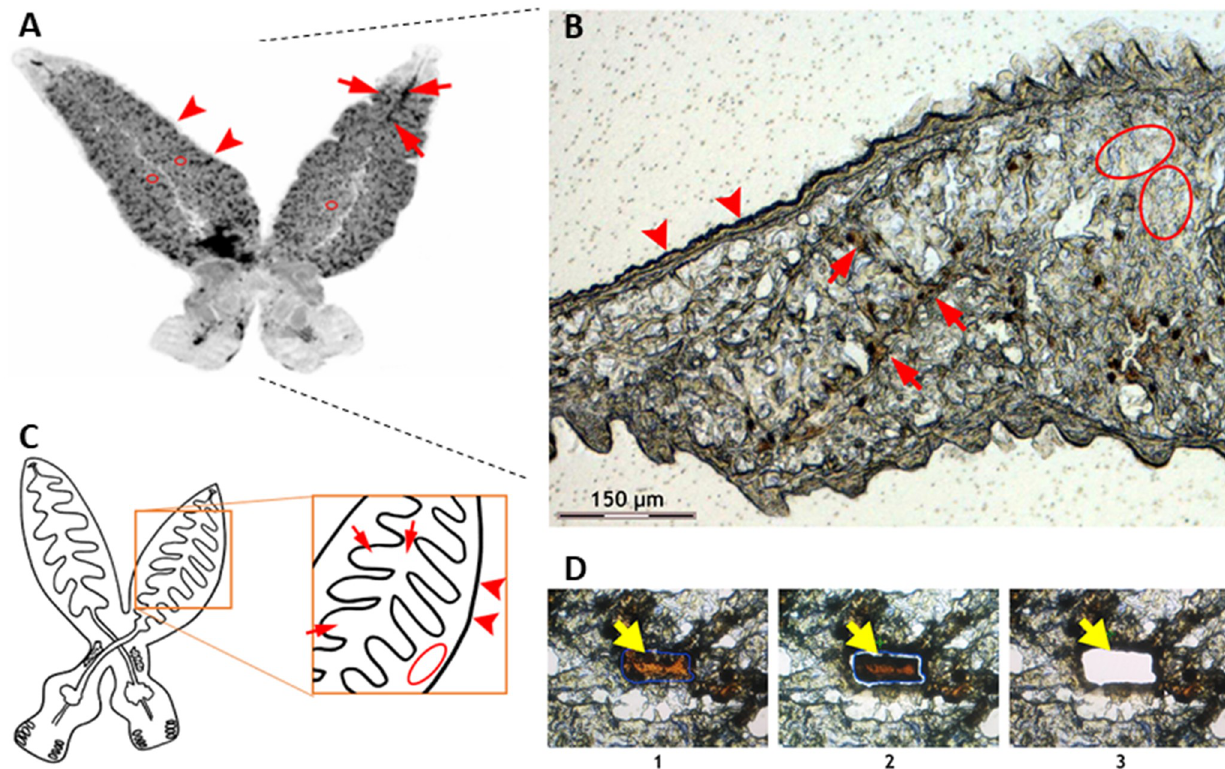
Fig 1. Laser microdissection of chosen tissues of E . nipponicum . (A) An overview of E . nipponicum body. (B) Part of microdissected section. A branched intestine filled with host blood is clearly visible (red arrow). Tegument is visible at the edge of the section (red arrowhead). Parenchyma is the area with no visible organelles (red ovals). (C) A schematic drawing of worm anatomy and dissected areas. (D) Microdissection process: 1) selection of desired area; 2) laser section; 3) catapulting specimen to collection tube. Yellow arrows point to the dissected area.